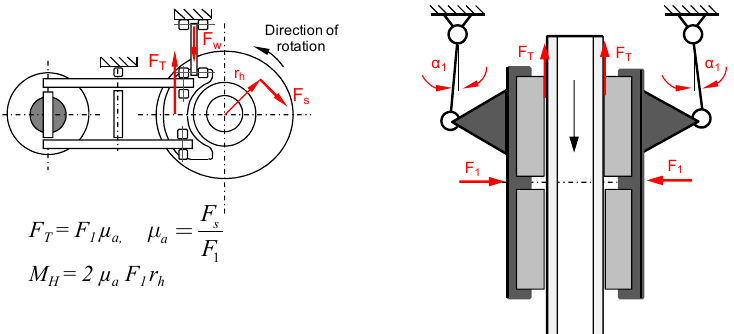
Figure 7. Physical model of friction in a disc brake, F1—forces acting on the brake pad holder, F s —tangential force related to the braking radius r h , F T —frictional forces, α 1 —angle of inclination of the vertical lever during braking, F W —force of inertia on the circumference of the wheel during, µa—coefficient of friction at rest, M H —braking torque.